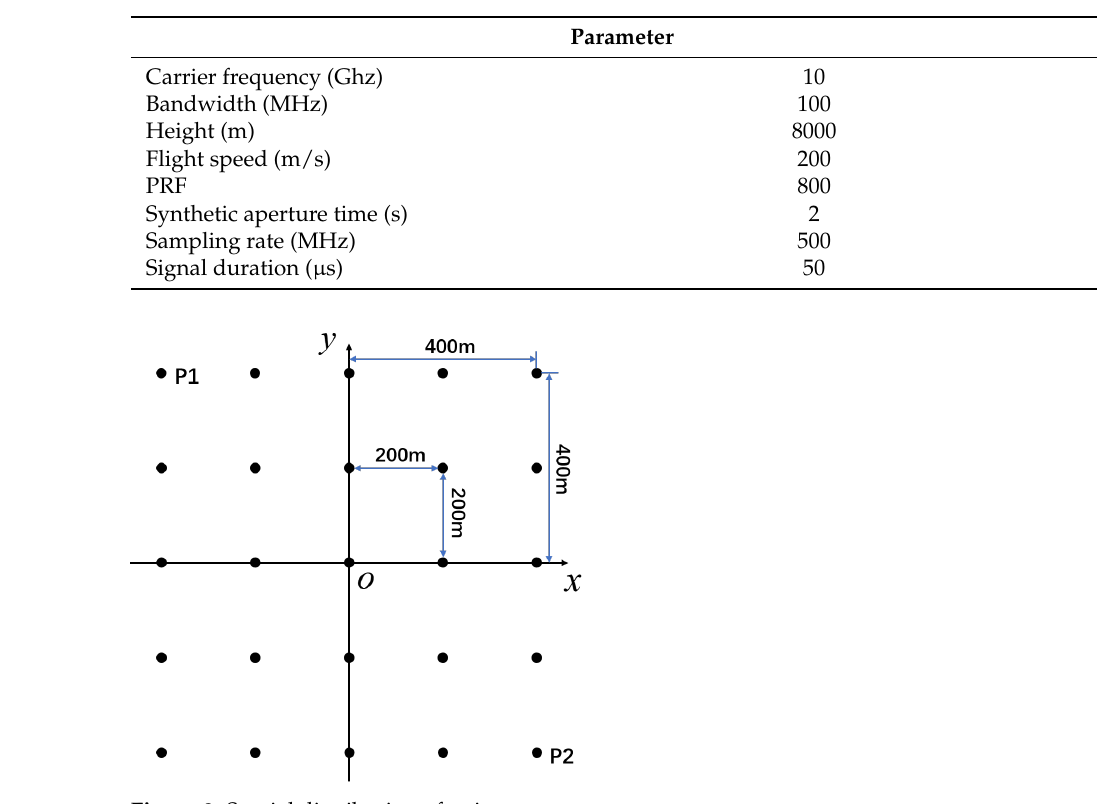
Table 1. Simulation parameters of monostatic SAR.